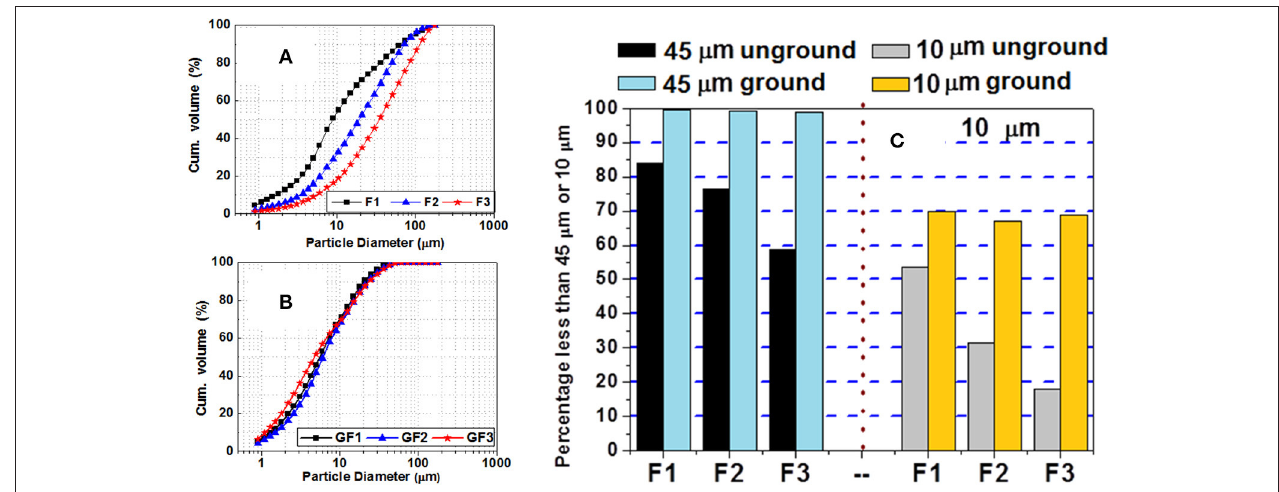
FIGURE 1 | Cumulative volume of (A) initial and (B) ground ash, and (C) percentage of particles under 45 and 10 µ m before and after